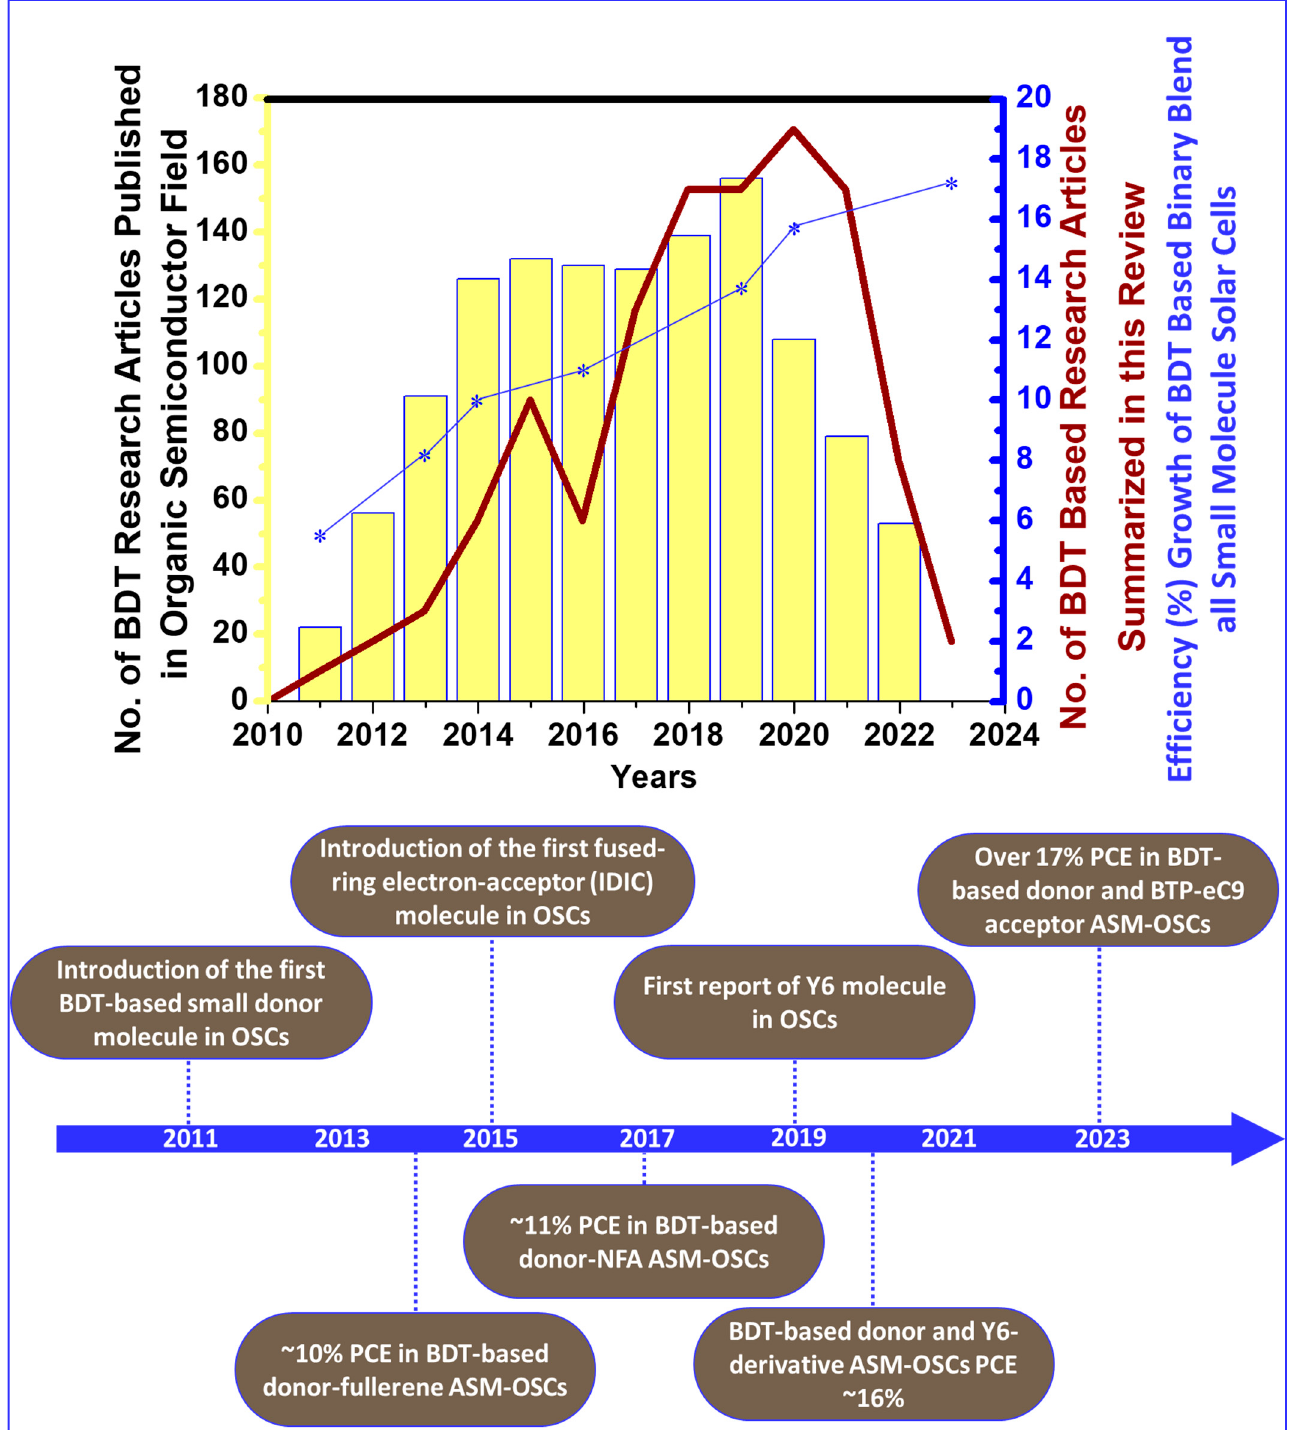
Figure 1. The number of BDT research articles published in the organic semiconductor field (through the keyword “benzo[1,2-b:4,5-b ′ ]dithiophene (BDT)” on Web of Science) and a brief timeline of the development of BDT donor-based ASM OSCs.